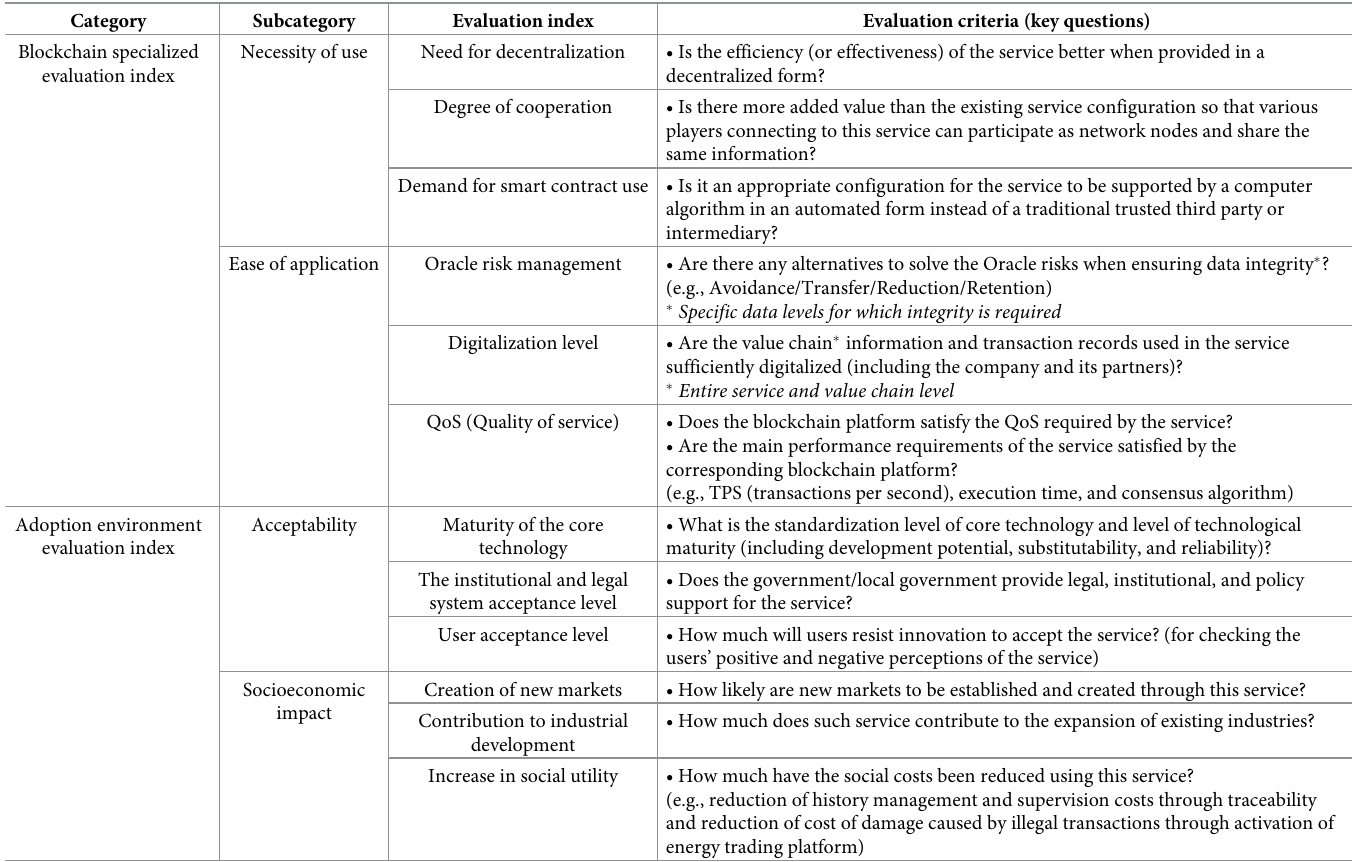
Table 3. The proposed framework of the blockchain service utility evaluation